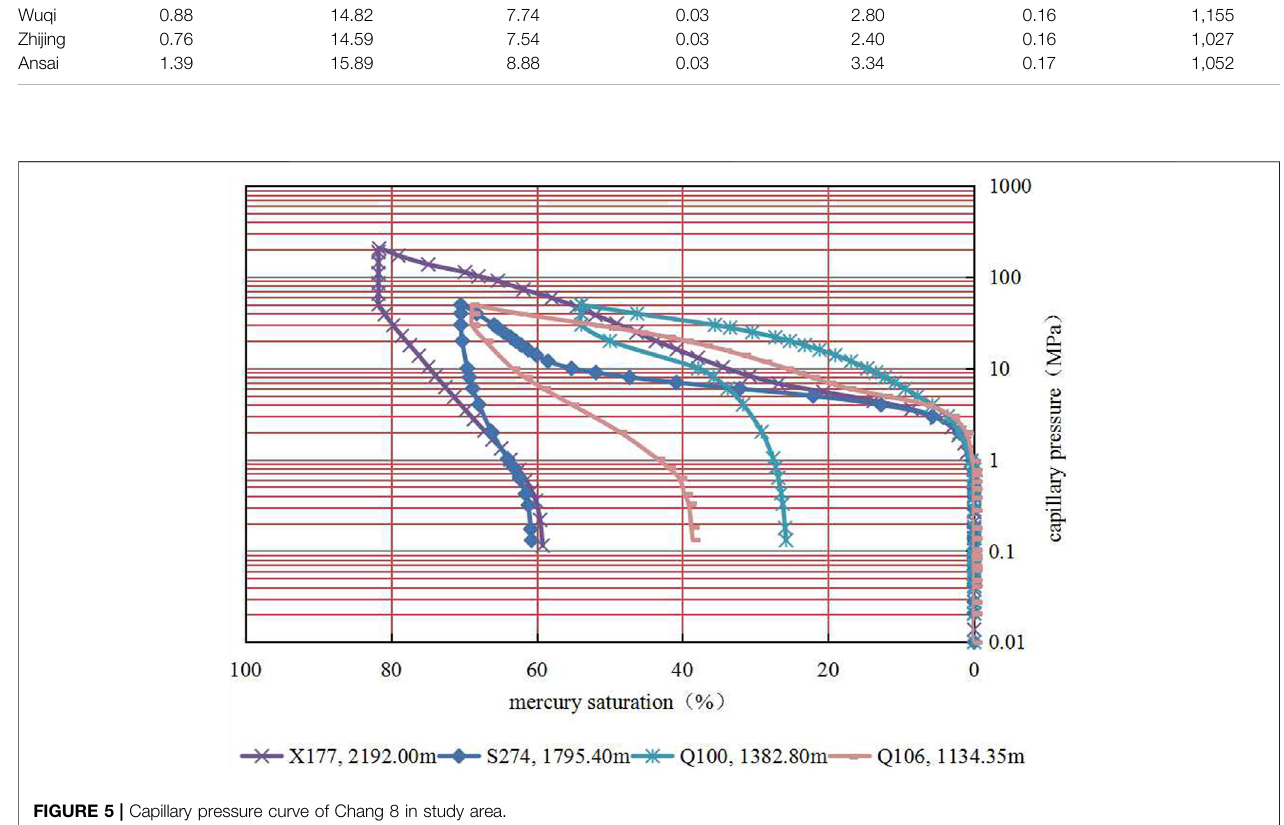
Frontiers in Physics |